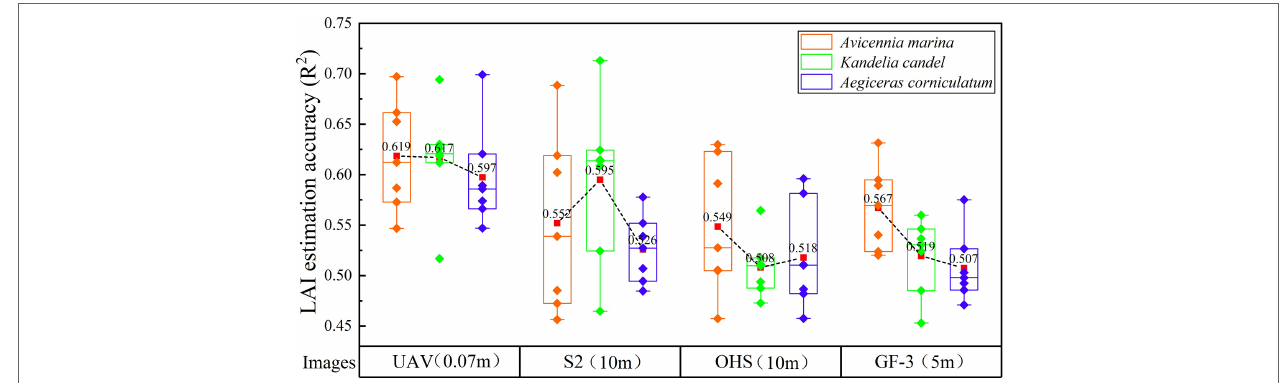
FIGURE 5 | Statistical analysis of optical and SAR images for LAI